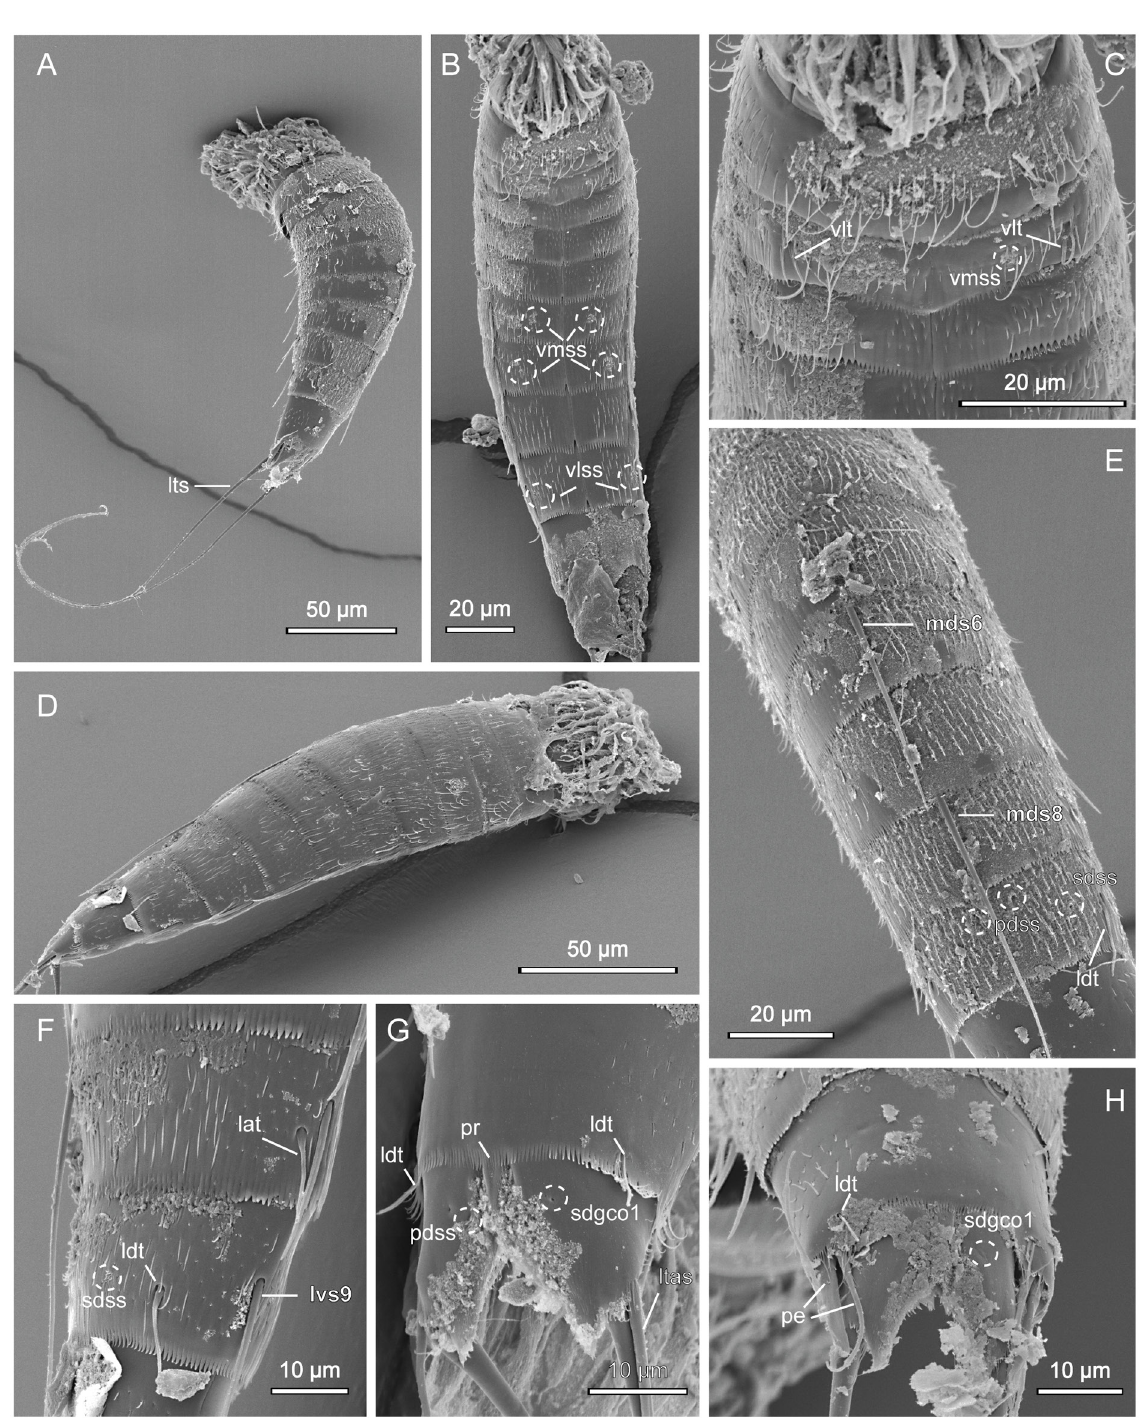
Fig. 16. Scanning electron micrographs showing overviews and details of Echinoderes gandalfi sp. nov. A . Lateral overview. B . Ventral overview. C . Segments 1 to 4, ventral view. D . Lateral overview. E . Segments 4 to 10, dorsal view. F . Segments 8 to 9, lateral view. G . Segments 10 to 11 of female, dorsal view. H . Segments 10 to 11 of male, dorsal view. Abbreviations: see Material and